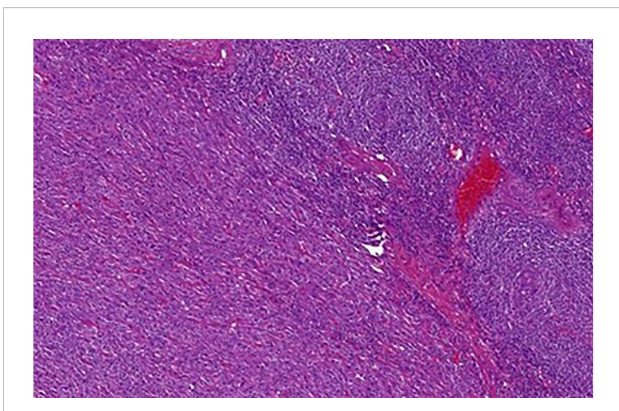
FIGURE 10 Castleman disease, hyaline-vascular type with transformation into follicular dendritic cell sarcoma: Abnormal follicles with concentric layering of lymphocytes in the mantle zone are evident in the upper right. The bottom left part of the image shows transformation into follicular dendritic cell sarcoma. The tumor cells were diffusely CD35 and CD21 positive (not